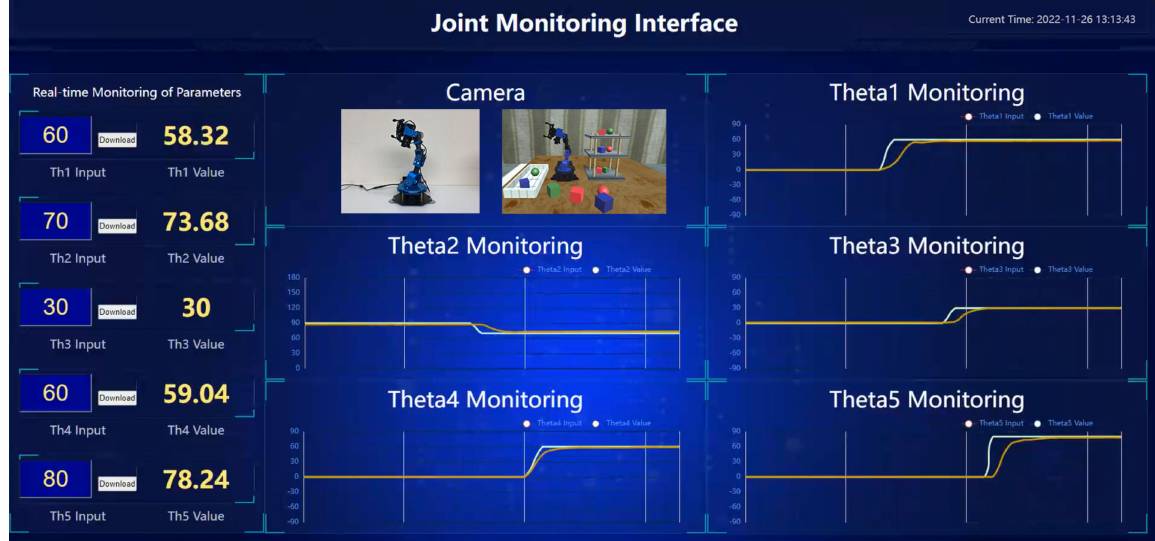
Figure 9. Graphic user interface of